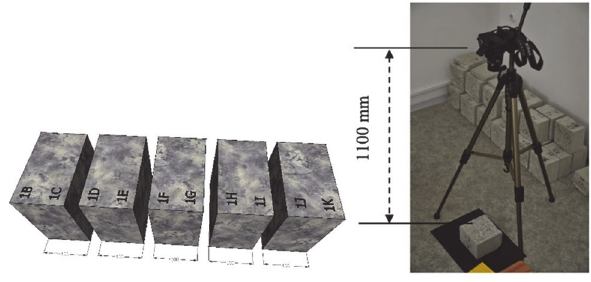
Figure 3. Imaging method